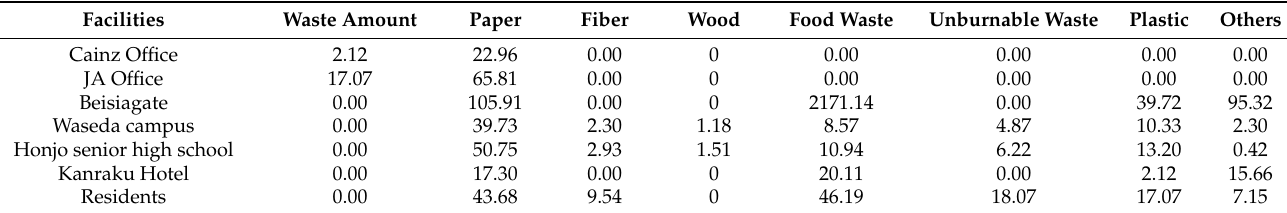
Table 4. Waste amount of each waste category for each facility (ton/year).